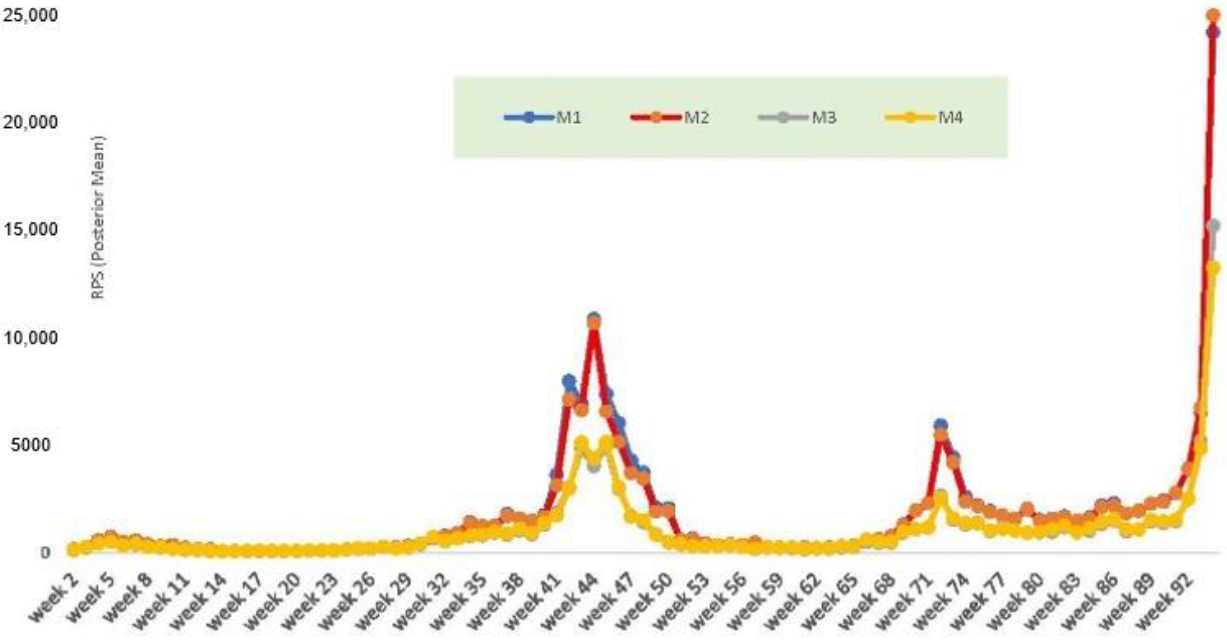
Figure 2. Ranked probability score by week; models compared.